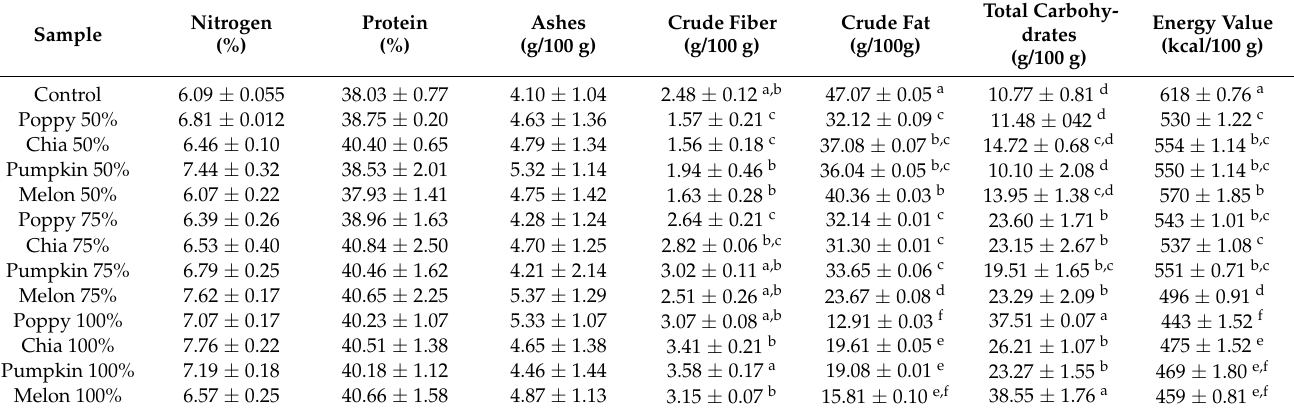
Table 5. Results obtained for the nutritional parameters analyzed in the different reformulated